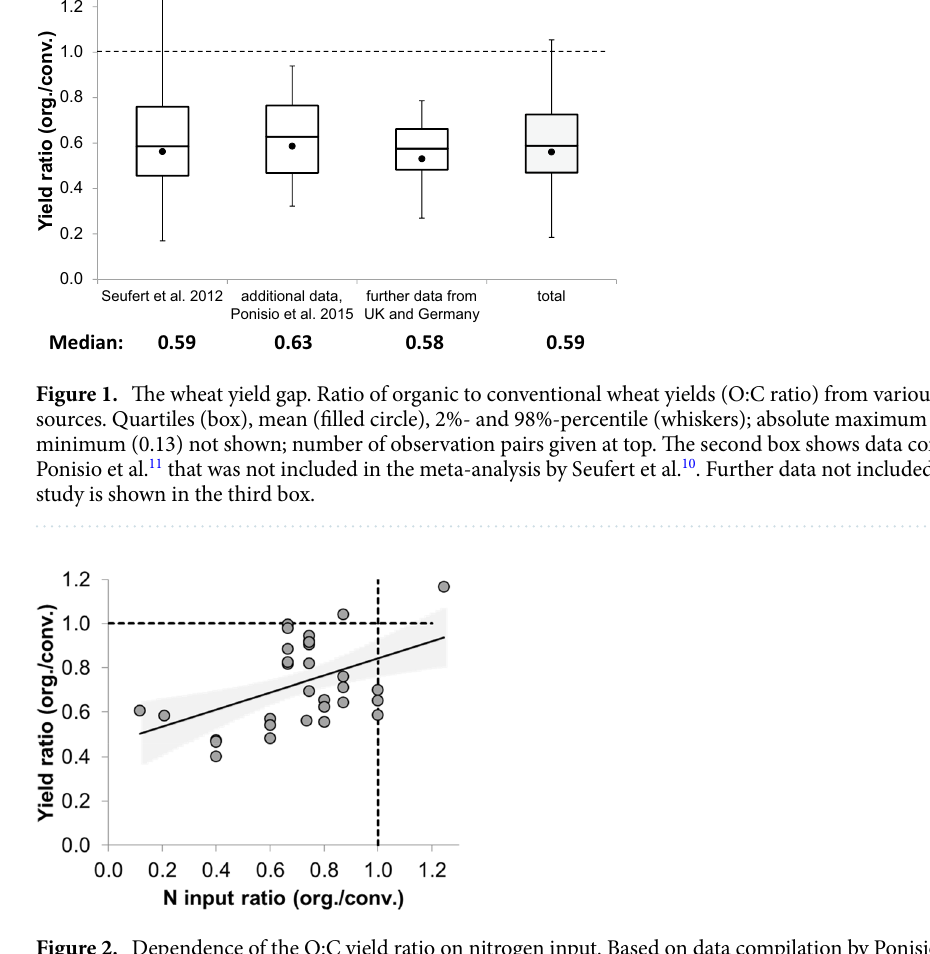
Figure 2. Dependence of the O:C yield ratio on nitrogen input. Based on data compilation by Ponisio et al. 11 ; cases restricted to those where N input was 120–150 kg N ha −1 in conventional